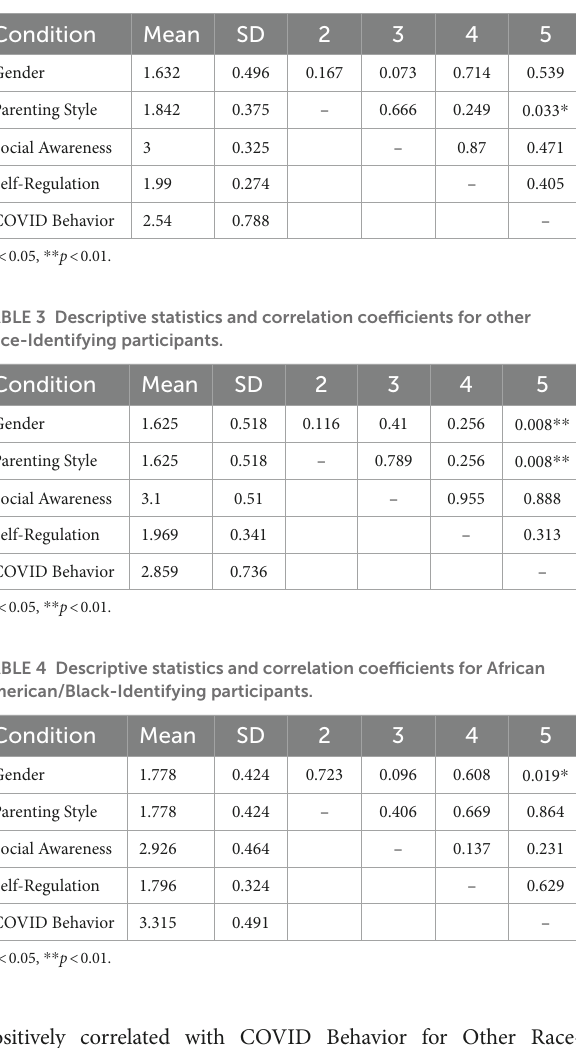
TABLE 2 Descriptive statistics and correlation coefficients for White- Identifying participants.